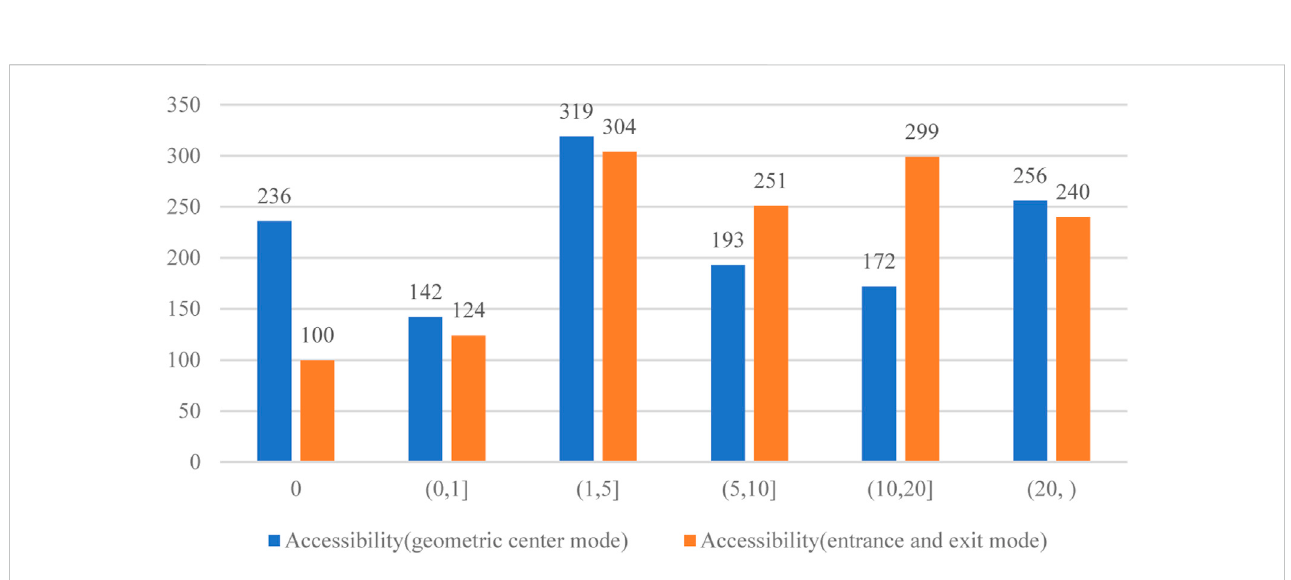
FIGURE 4 Statistical chart of two accessibility levels at the scale of residential